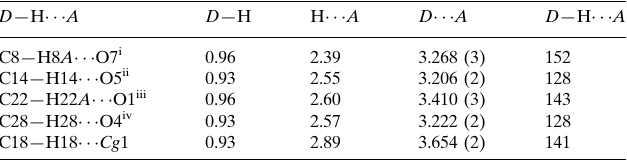
Hydrogen-bond geometry (A˚ , (cid:1)